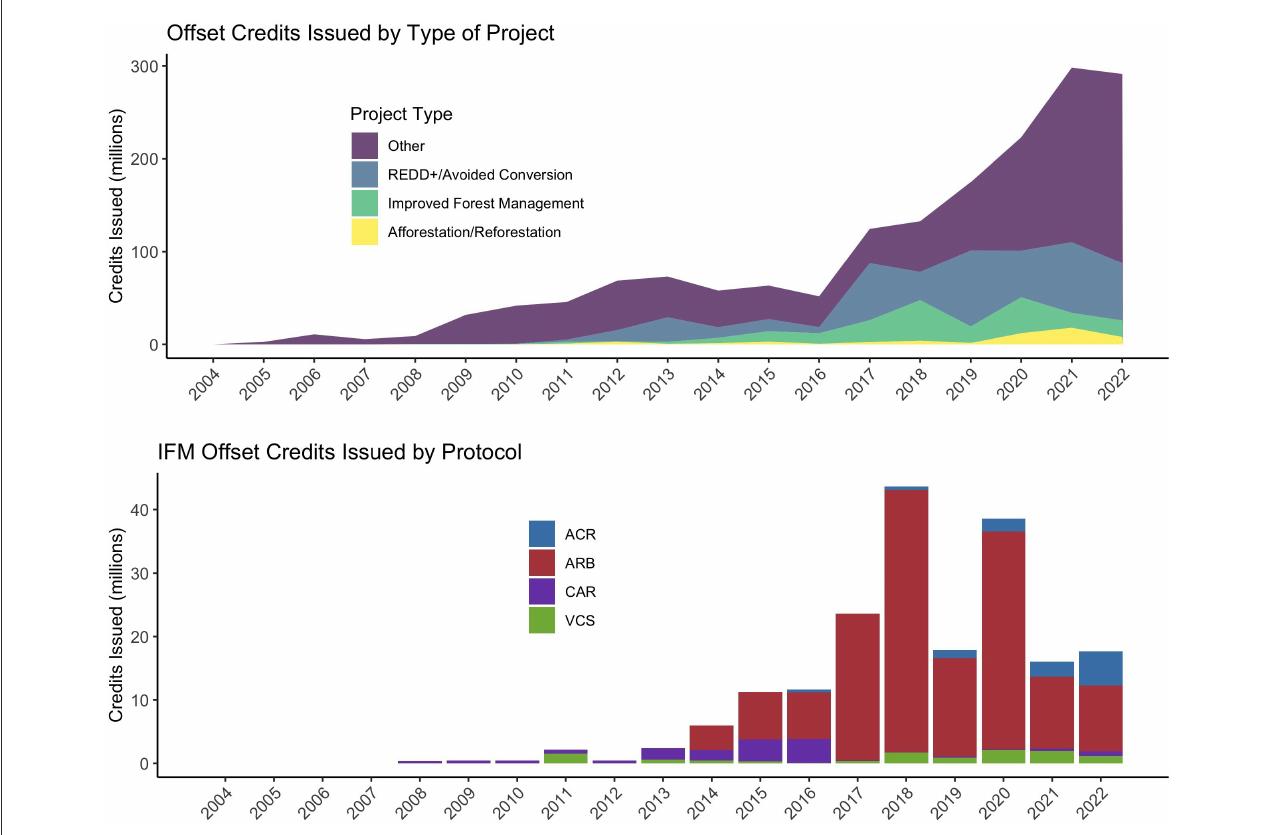
FIGURE1 Current trends in forest-based carbon offset markets (based on data from So et al., 2023). The upper panel shows the breakdown of credits issued by project type for forest and non-forest carbon offset projects. The lower panel shows the trend in IFM credit issuances by